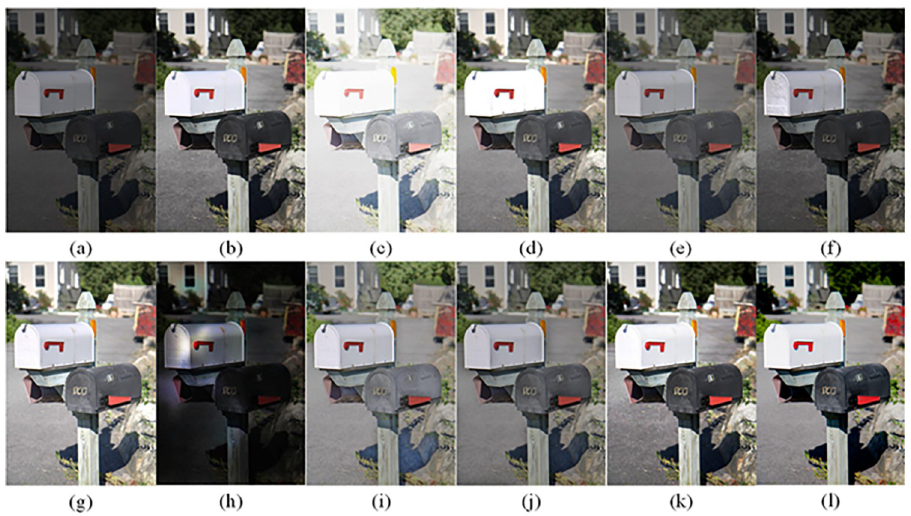
Fig 27. Comparisons of the ten algorithms in enhancing low-light image 17. (a) low-light image (b) AGCWD (c) Al-Ameen (d) BHE2PL (e) BIMEF (f) BPDHE (g) LIME (h) MSRCR (i) NPEA (j) SRIE (k) OURS (l) Normal light image.